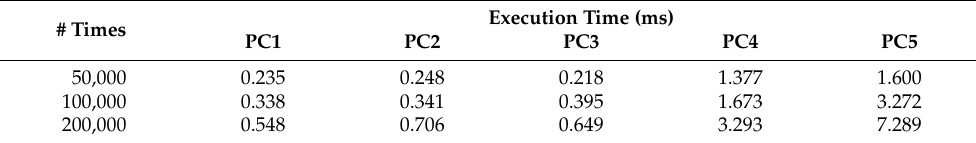
Table 14. Performance evaluation of bridge identical